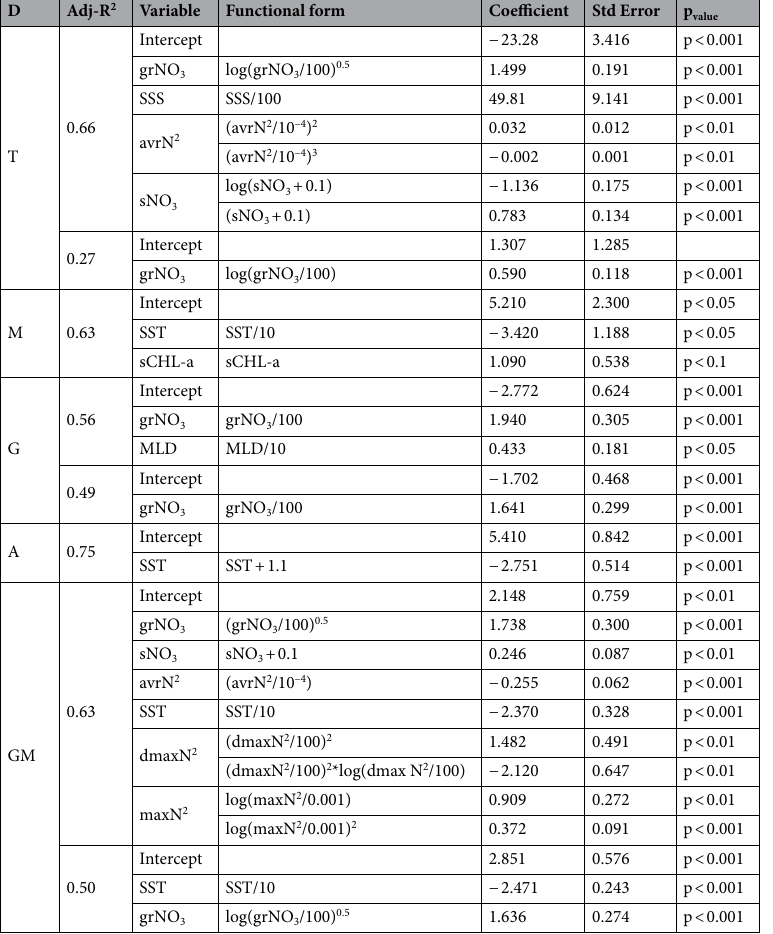
Table 3. Regression equations obtained by the MFP method in each domain (D) by using exploratory and 3-variable models. T indicates tropical and subtropical regions, M Mediterranean Sea, G Galician coastal upwelling, A Antarctic Peninsula, and GM global model built with the complete dataset except those collected in the Antarctic Peninsula. Exploratory models used all the predictors, and 3-variable models only used sea surface temperature (SST), surface chlorophyll-a (sCHL-a) or vertical nitrate gradient (grNO 3 ). Adj-R 2 is adjusted squared coefficient of determination, and Std Error standard error. The number of stations used to build each model is indicated in Table